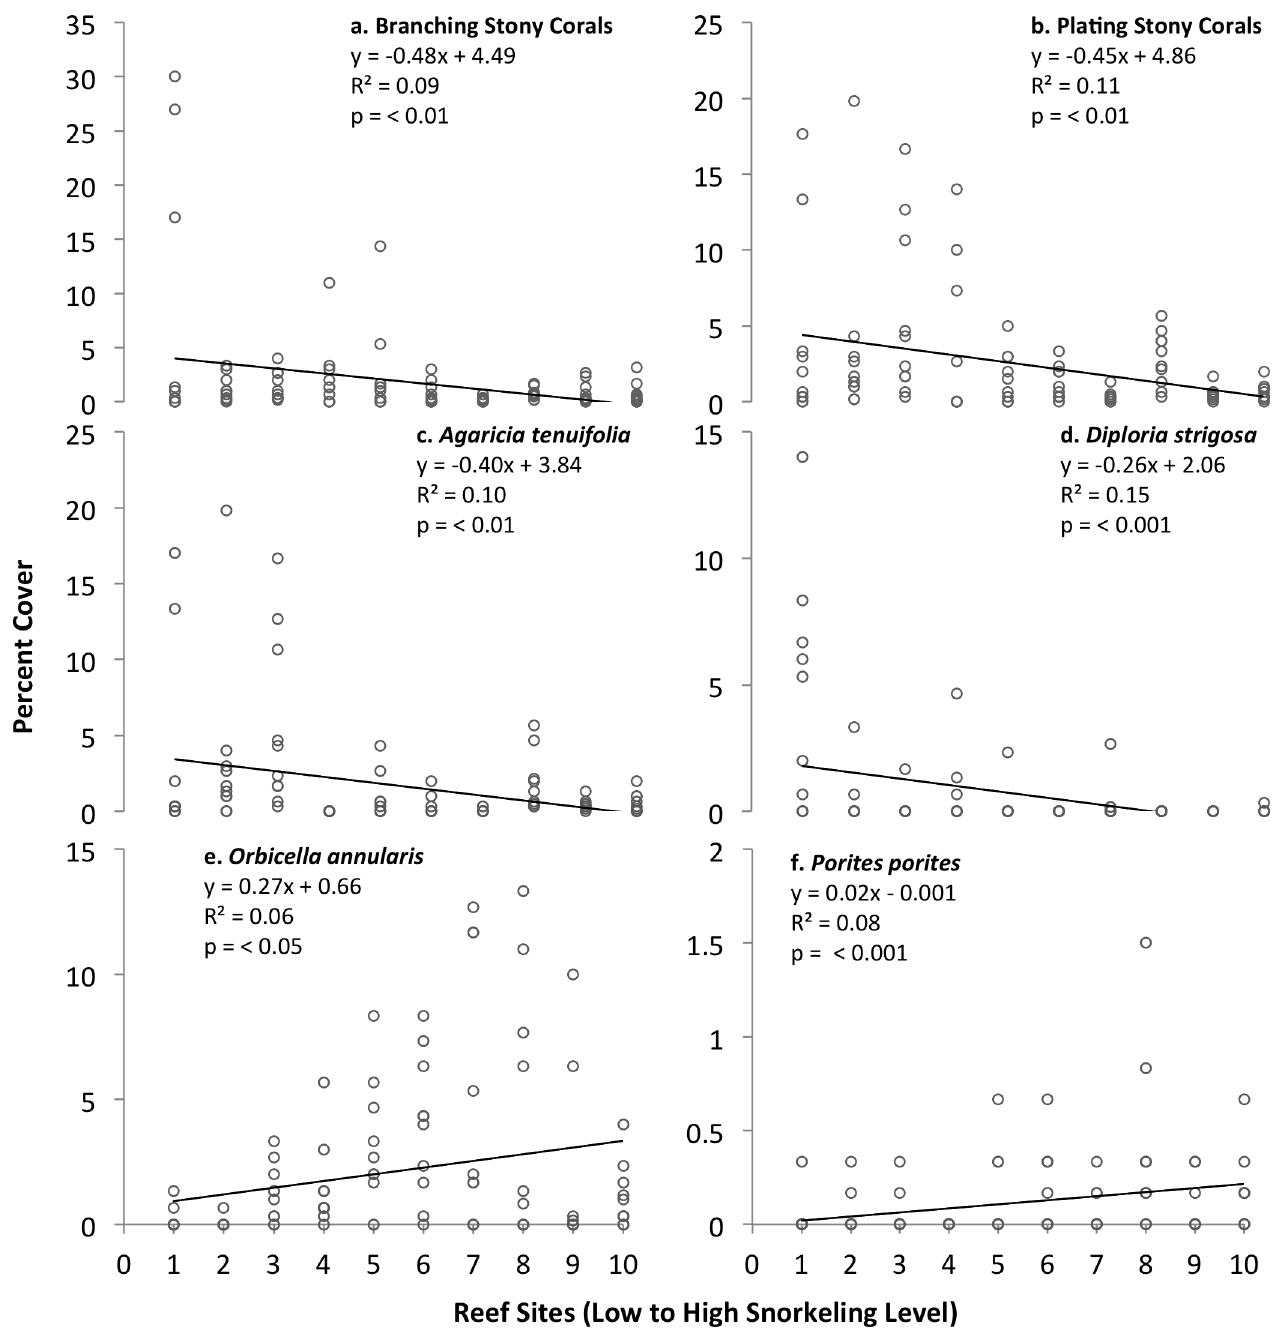
Fig 4. Growth form (a,b) and species-level (c-f) variation in the percent cover of stony corals among patch reefs ranked by level of snorkeling in Akumal Bay, Mexico. N = 10 transects examinedper